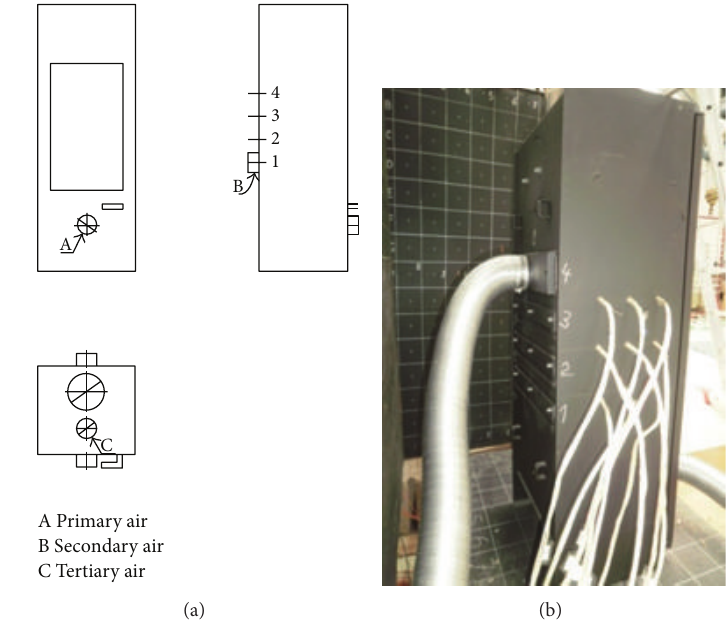
Figure 3: Position of combustion air inlets.